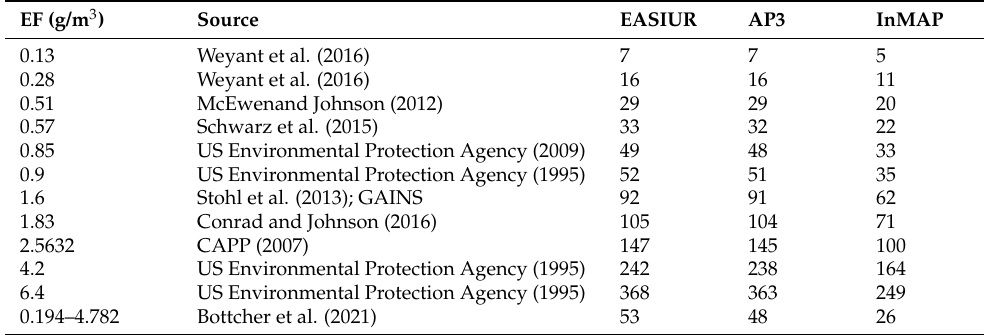
Table A2. Predicted mortality from three reduced-form models using the alternate emission factors for the flaring